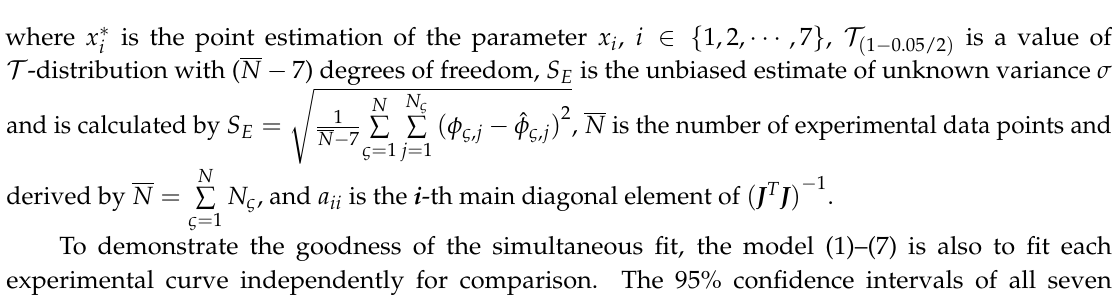
x . Figure 7. Sensitivity of the PDD model to parameter ( a ) x 1 ; ( b ) x 2 ; ( c ) x 3 ; ( d ) x 4 ; ( e ) x 5 ; ( f ) x 6 and ( g ) x 7